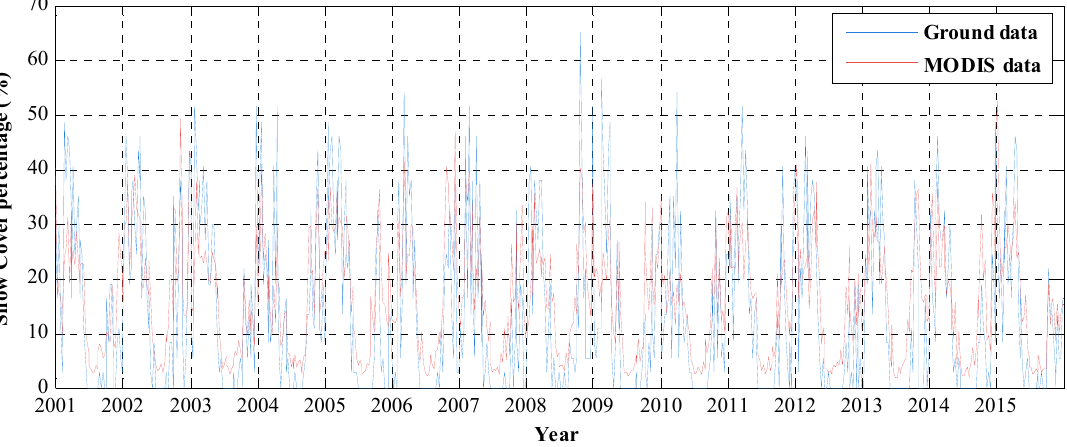
Figure 12. The eight-day snow cover (in %) in Tibet during 2001–2015. The red and blue curves represent the MODIS and station data, respectively. Table 7. The annual average and maximum MODIS and station snow cover.